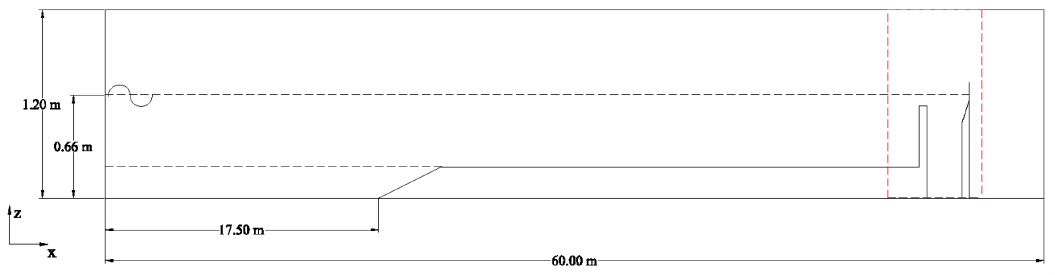
Figure 2. Configuration of the physical wave tank in the experiment